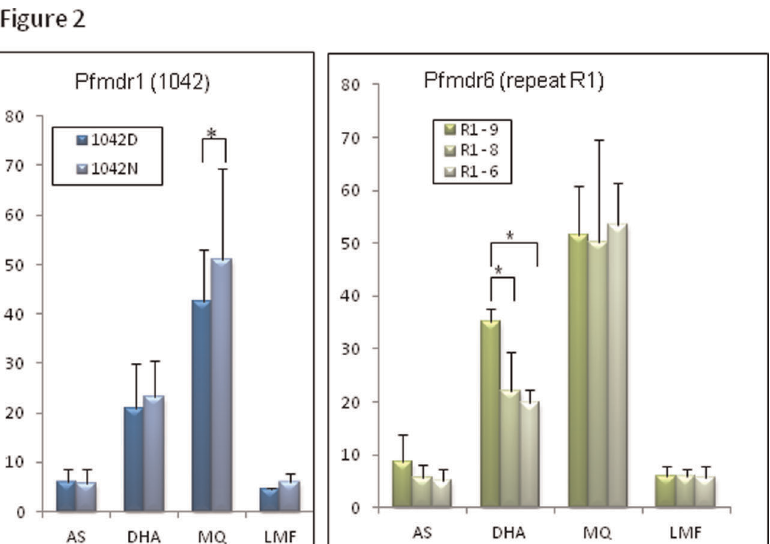
Figure 2. Association of SNPs and other polymorphisms in candidate genes with drug responses. Only significant association of a SNP in pfmdr1 and number variation of repeat R1 in pfmdr6 with in vitro responses to artesunate (AS), dihydroartemisinin (DHA), mefloquine (MQ) and lumefantrine (LMF) are plotted here. IC 50 values are shown as mean + standard deviation. *indicates significant difference ( P , 0.05) in sensitivity between the two alleles.